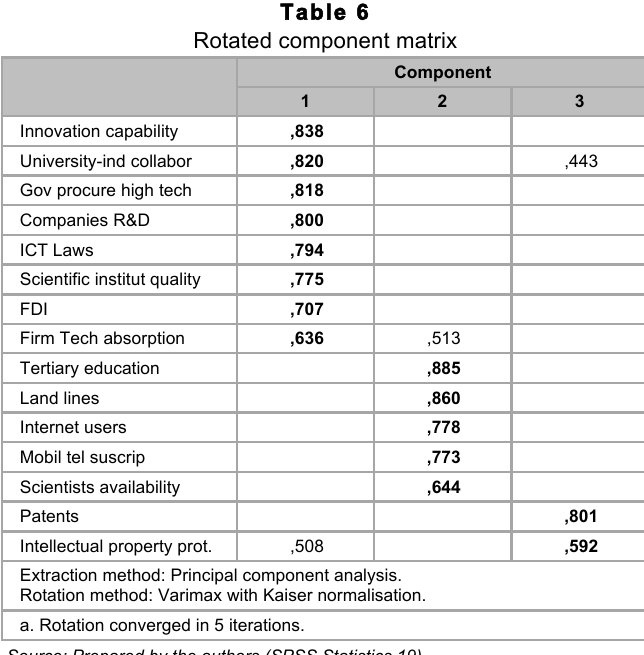
Rotated component matrix